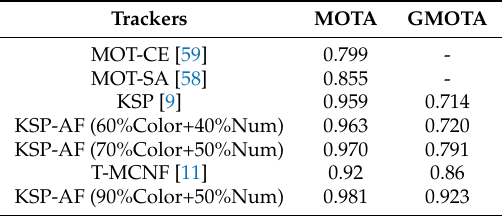
Table 2. The comparison of MOTA and GMOTA scores in APIDIS